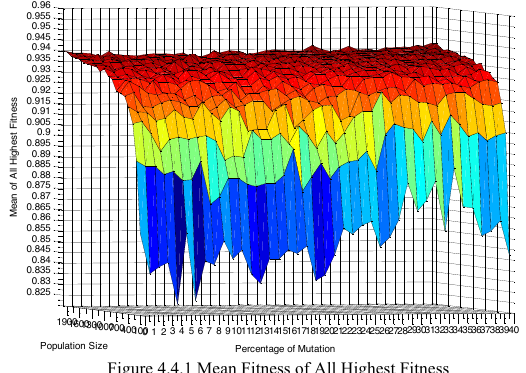
Figure 4.4.1 Mean Fitness of All Highest Fitness